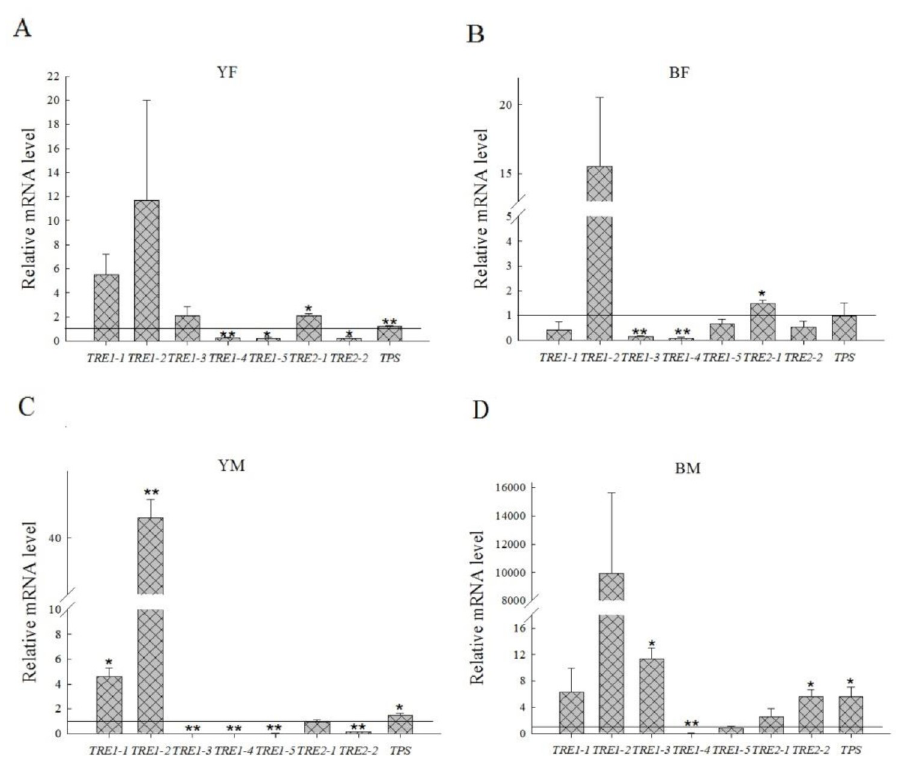
Fig 5. Comparison of changes in relative expression of seven TRE genes and one TPS gene between pre-wintering and over-wintering H . axyridis individuals in females and males of different colour forms. Relative gene expression is shown for yellow females (A), black females (B), yellow males (C) and black males (D). The expression level of these genes was determined with qRT-PCR using the housekeeping gene 18S as a reference. The relative expression of each gene in the pre-wintering population was used as control. The horizontal line represents the expression level at the stage of pre-wintering. Each bar depicts the mean (+ SD) of three samples. Asterisks show significant differences in relative expression (Tukey’s test, �� P < 0.01; � P <